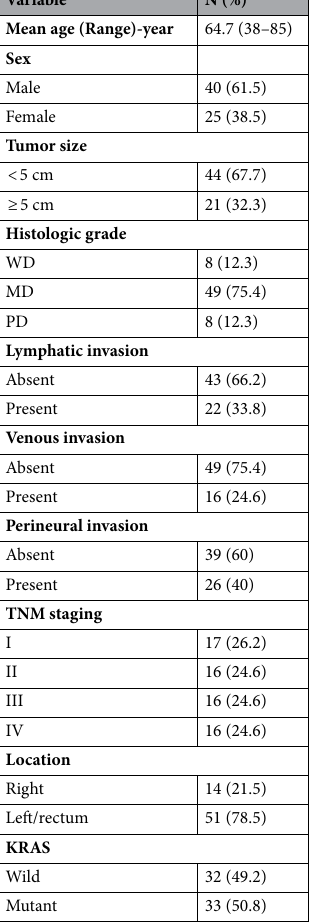
Table 1. Summary of clinicopathologic features of patients with colorectal cancer. WD well differentiated, MD moderately differentiated, PD poorly